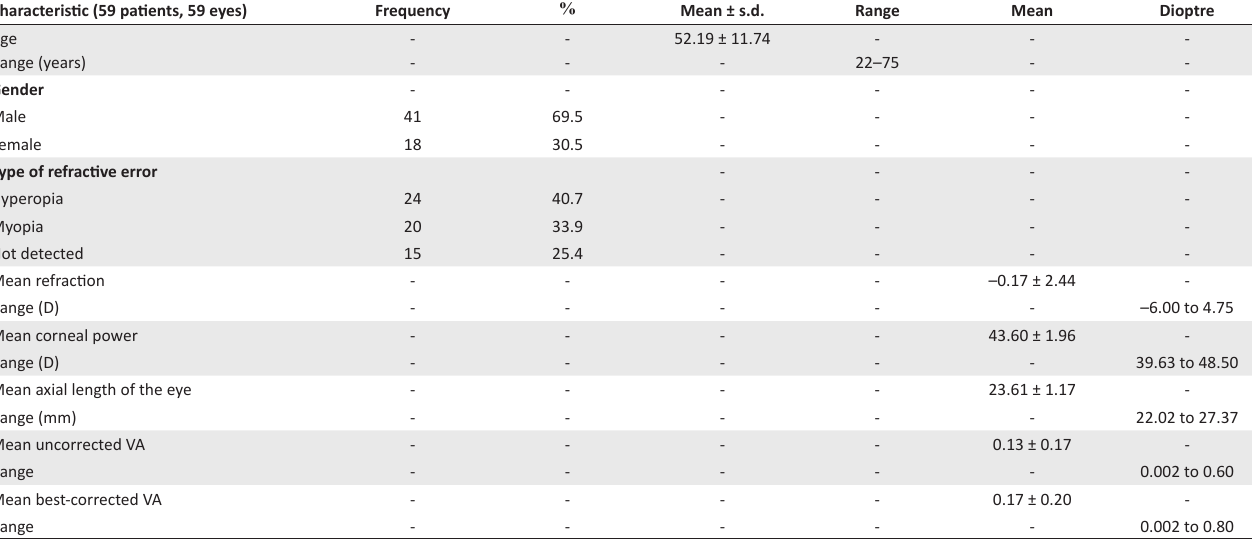
TABLE 1: Demographic and clinical characteristics of patients. Characteristic (59 patients, 59 eyes)